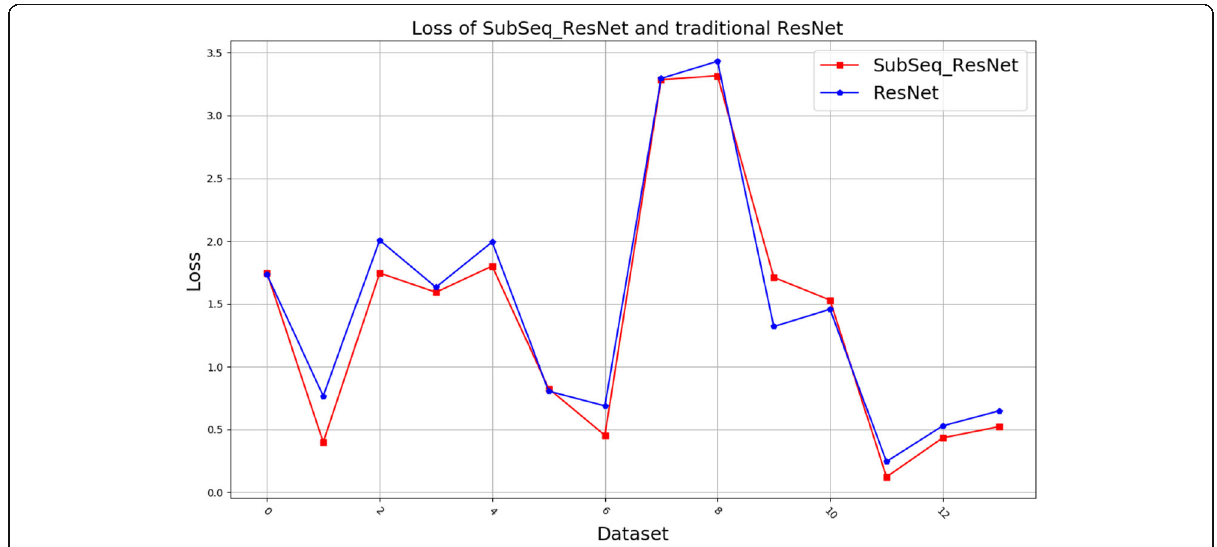
Fig. 12 The loss of the original sequence and feature subsequences on